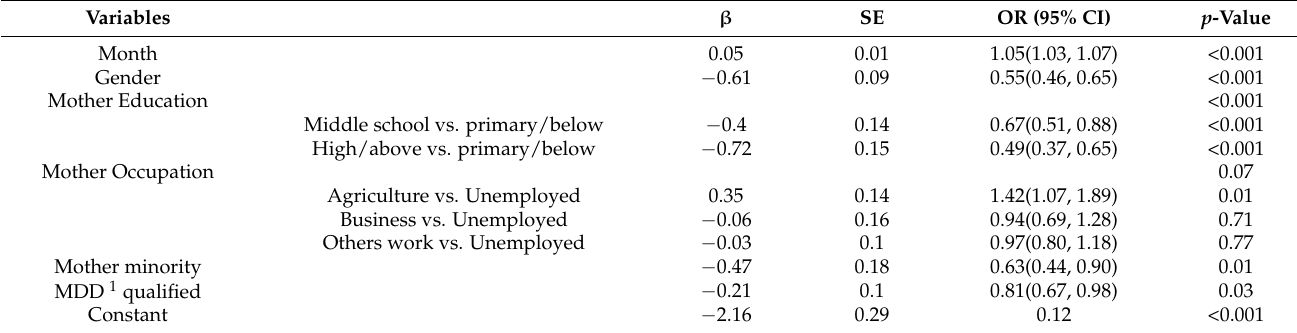
Table 4. Multivariate logistic analysis 2 of